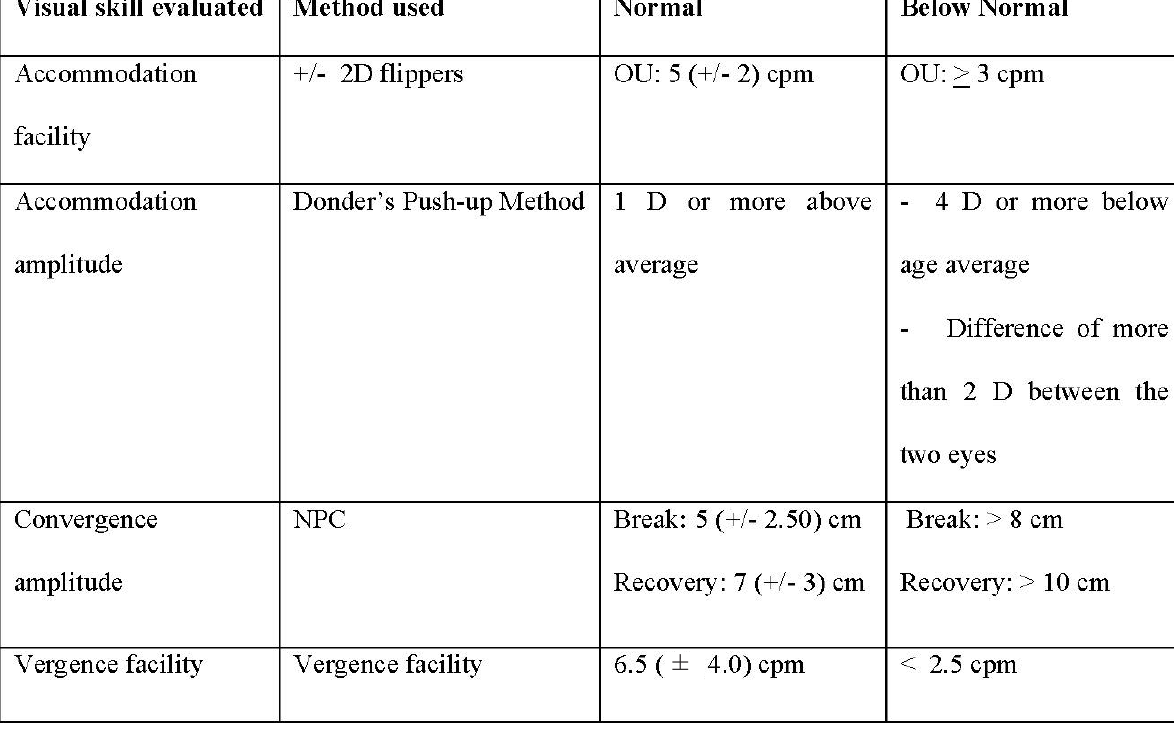
Table 2 The sample size in terms of